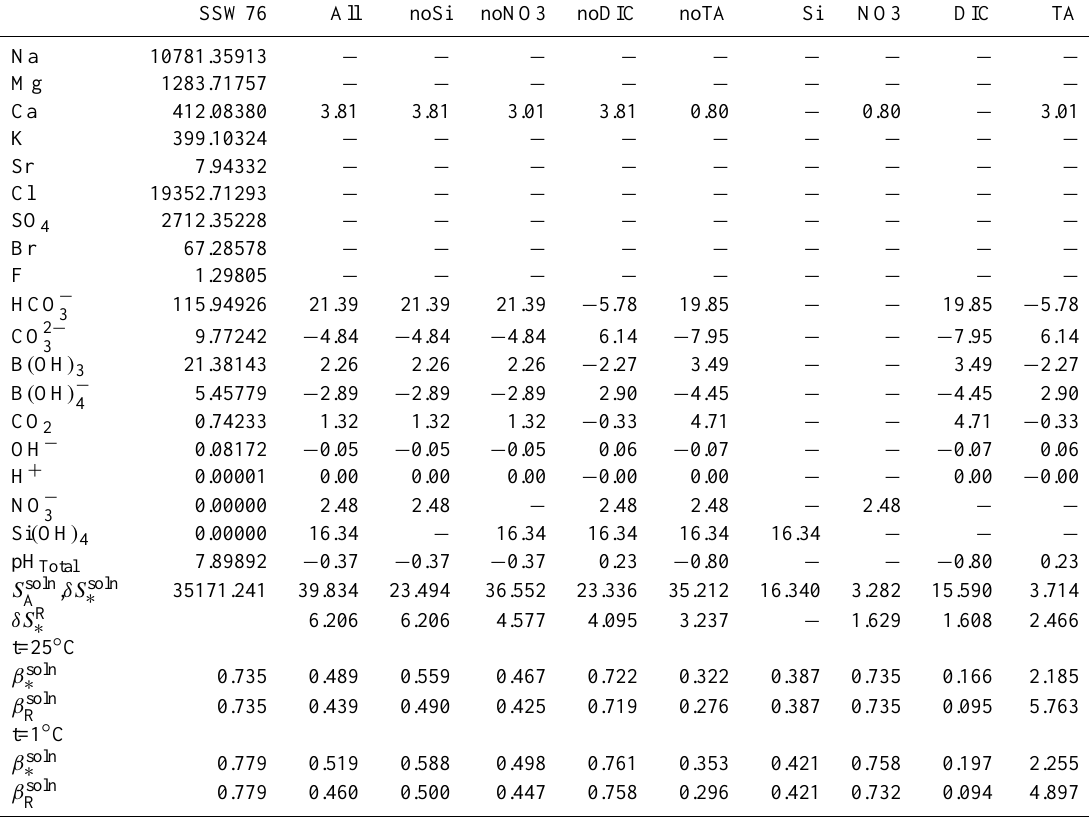
Table 5. Haline contraction coefficients for various combinations of biogeochemical processes. The first column is the composition of Standard Seawater (SSW76) with S P = 35, after Pawlowicz (2010), as well as the calculated β soln 1 ◦ C. Subsequent columns provide δc ∗ i , δS soln ∗ and S soln All concentrations are in mg kg − 1 . Perturbations of zero are denoted “ − ”. Perturbations denoted “0.00” are nonzero, but too small to affect